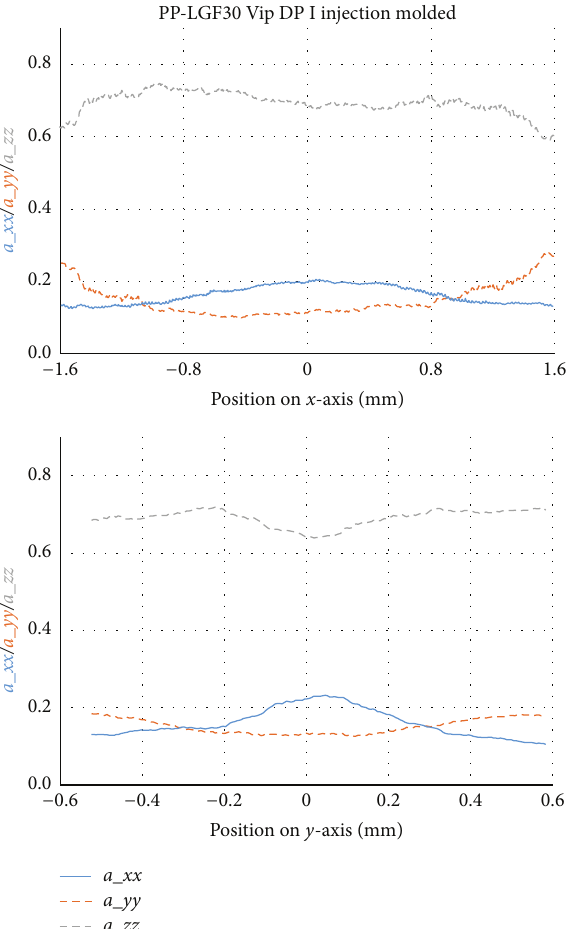
Figure 25: Progress of the fiber orientation along the 𝑥 - and 𝑦 -axis in the weld of injection molded plates in vibration welding of PP-